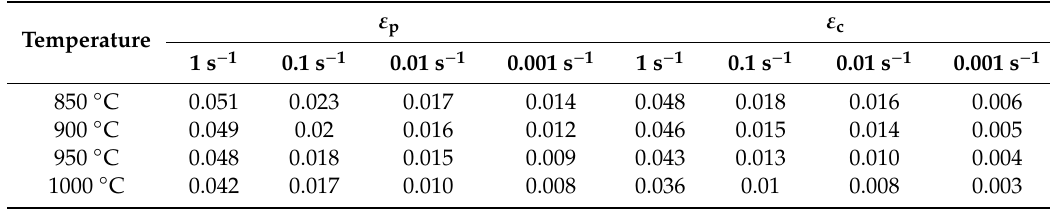
Table 2. The values of p